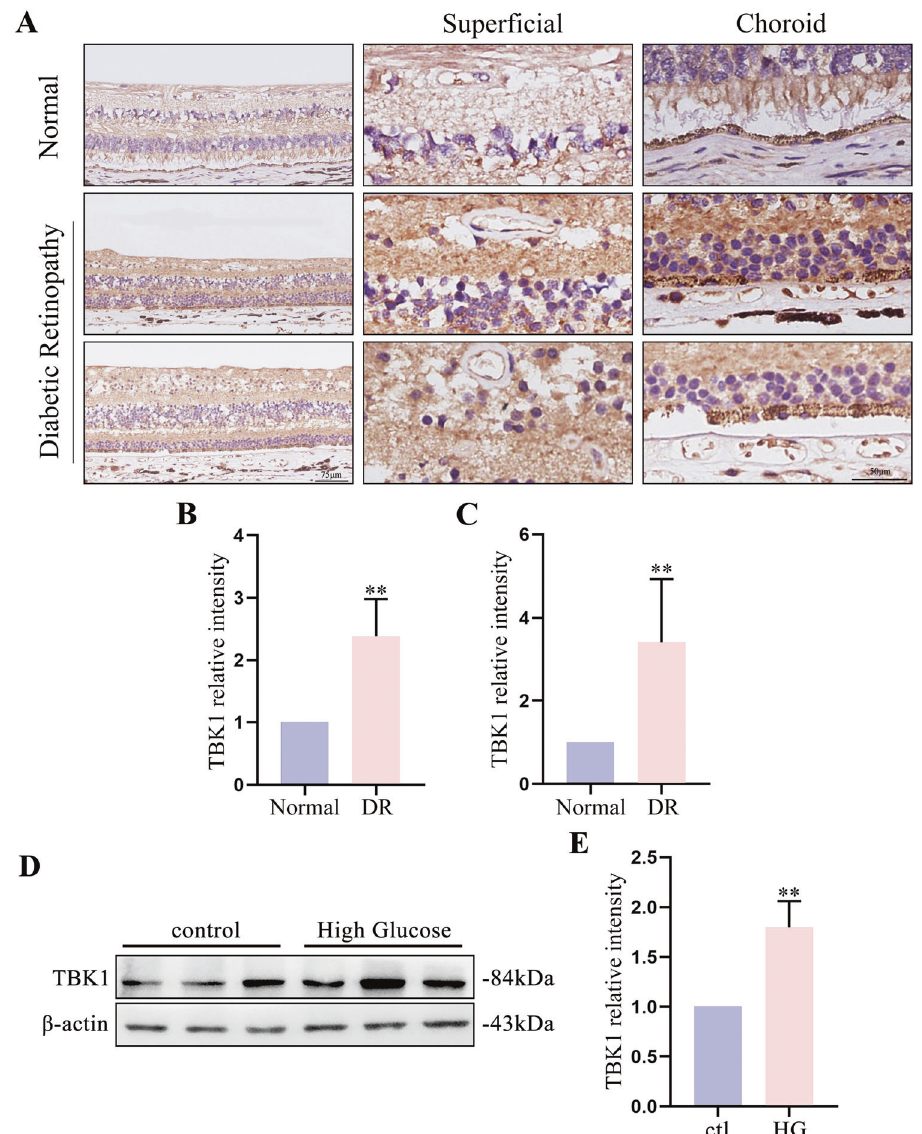
Fig. 7 TBK1 expression was increased in human diabetic retinas. A Representative images of TBK1 immunostaining in human retinas. TBK1 was increased in retinal and choroidal vasculature with DR. B Statistical analysis of TBK1 expression in retinal super fi cial vessels in A . The data were means ± SD of three samples/group and assessed by student ’ s t -test. C Statistical analysis of TBK1 expression in choroidal vessels in A . The data were means ± SD of three samples/group and assessed by Welch ’ s t -test. D TBK1 expression in HRCECs was tested by western blot assay. Cells were treated with 30 mM glucose to establish a high glucose model. E Statistical analysis of the data shown in D . The data were means ± SD of three replicates/groups and assessed by student ’ s t -test. ** P < buffer, followed by western blot assays. The secondary antibodies were as follows: anti-mouse IgG LCS(Abbkine, A25012) and anti-rabbit IgG LCS (Abbkine, A25022).